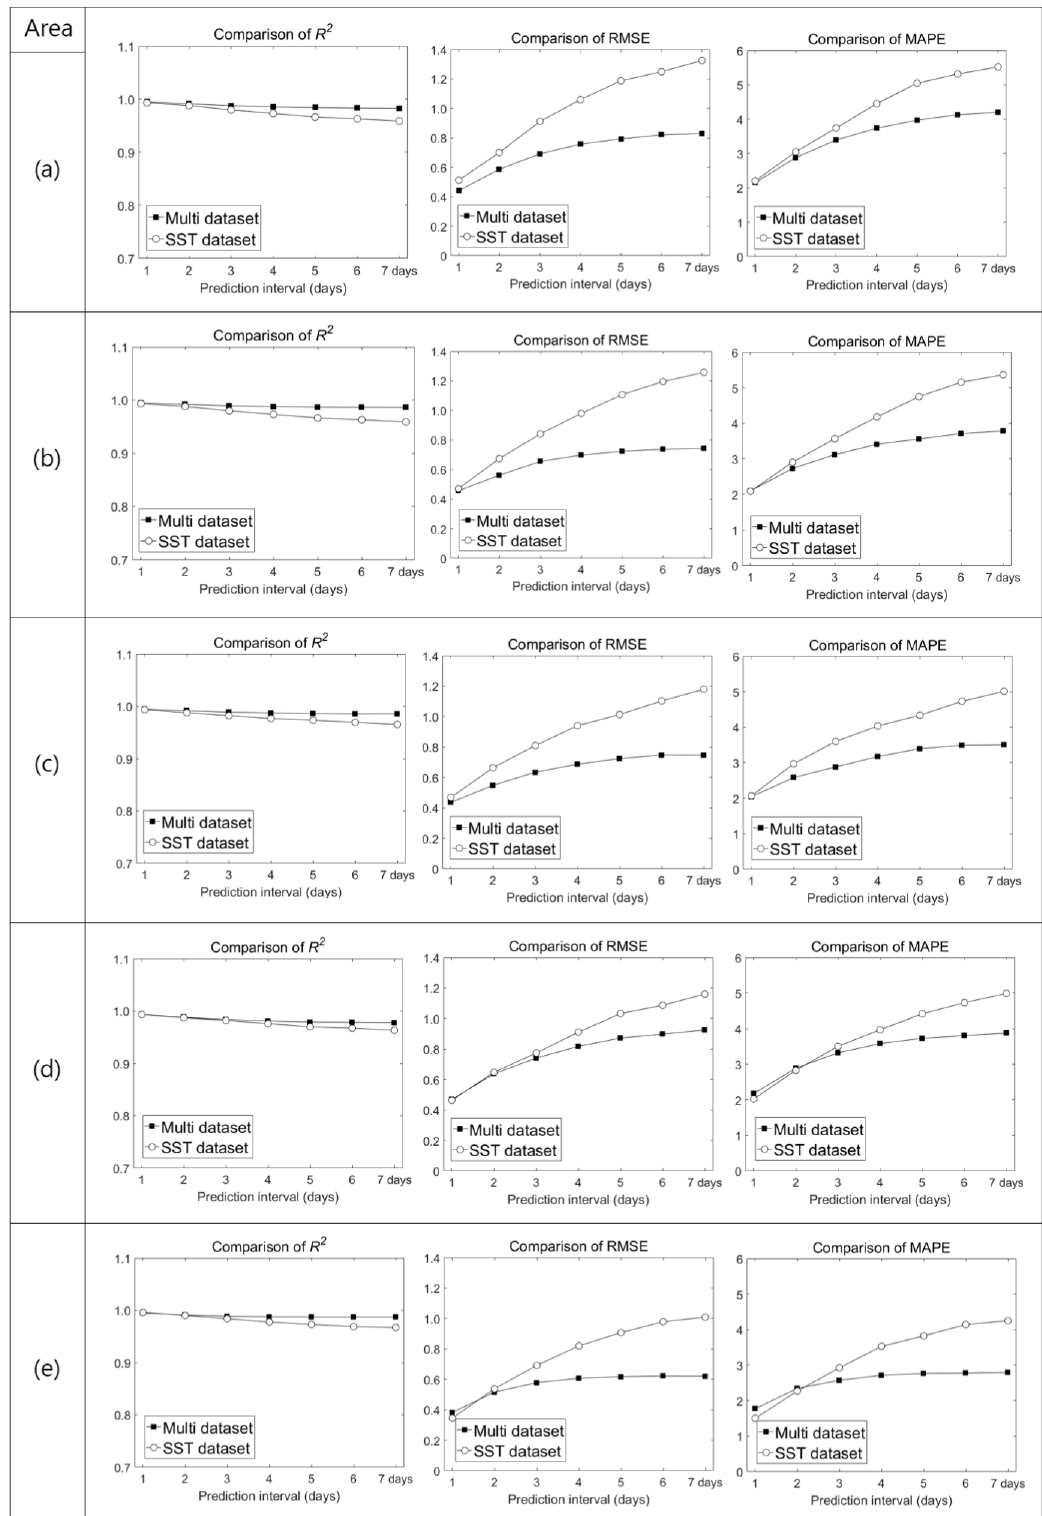
Figure A1. RMSE and MAPE values between LSTM results produced using the SST and multi datasets as input, for different areas.